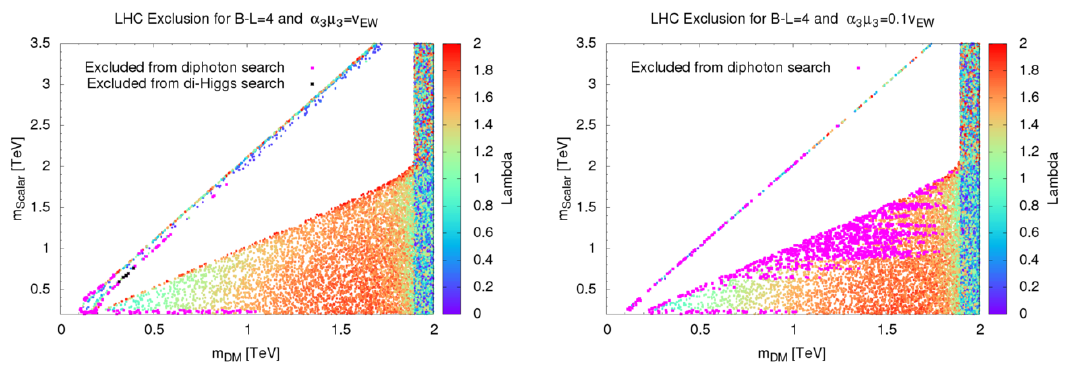
Figure 9 . The allowed parameter space in m DM (cid:0) m scalar plane satisfying the relic density for B (cid:0) L = 4 case. The left (right) panel is for (cid:11) 3 (cid:22) 3 = v EW (0 : 1 v EW ). In both the panels we vary (cid:21) in the range 0 to 2. The pink (black) points show the regions excluded from diphoton [39] (di-higgs [40]) search at